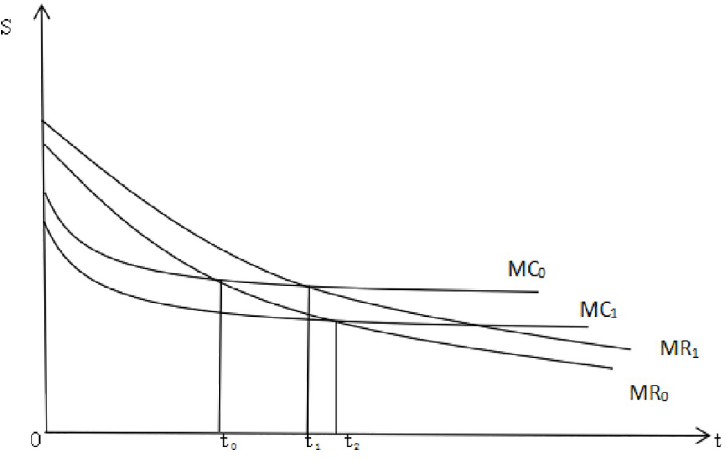
Fig 3. Comparison of the timing of social capital exit. (Source: author’s